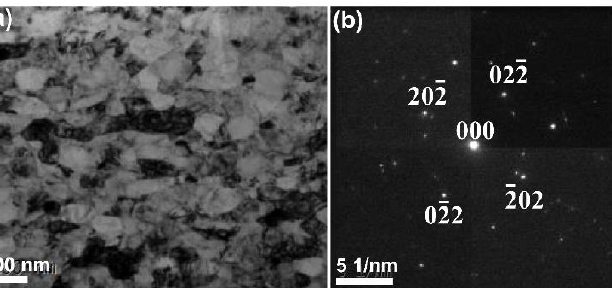
Figure 1. ( a ) Bright field TEM image and ( b ) selected-area electron diffraction (SAED) pattern of Monel 400 alloy.